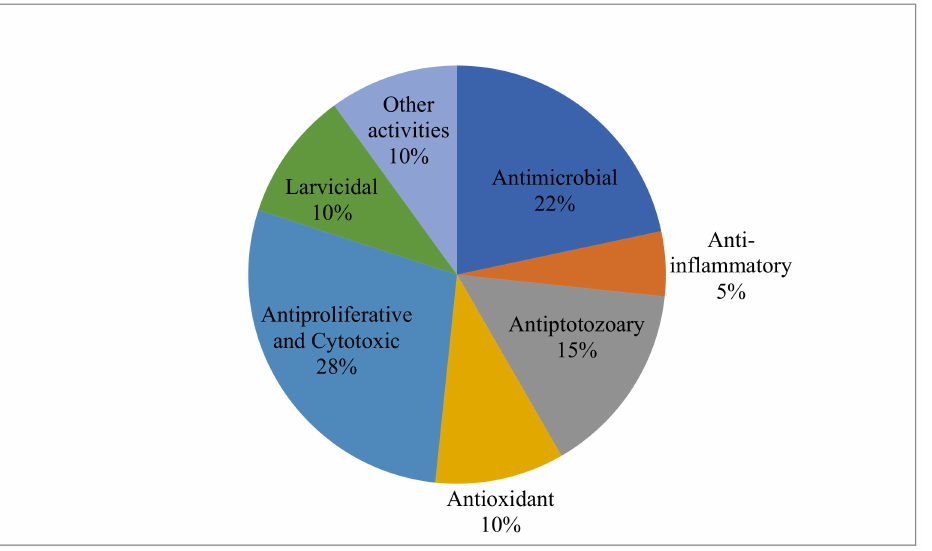
Figure 4. Distribution of studies on the biological activities of essential oils from Annonaceae species occurring in